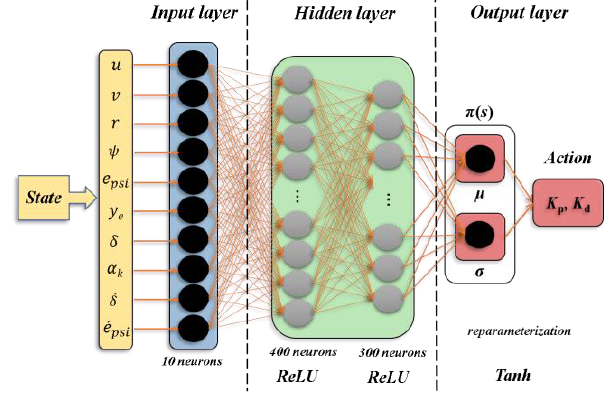
Figure 6. Actor network architecture.